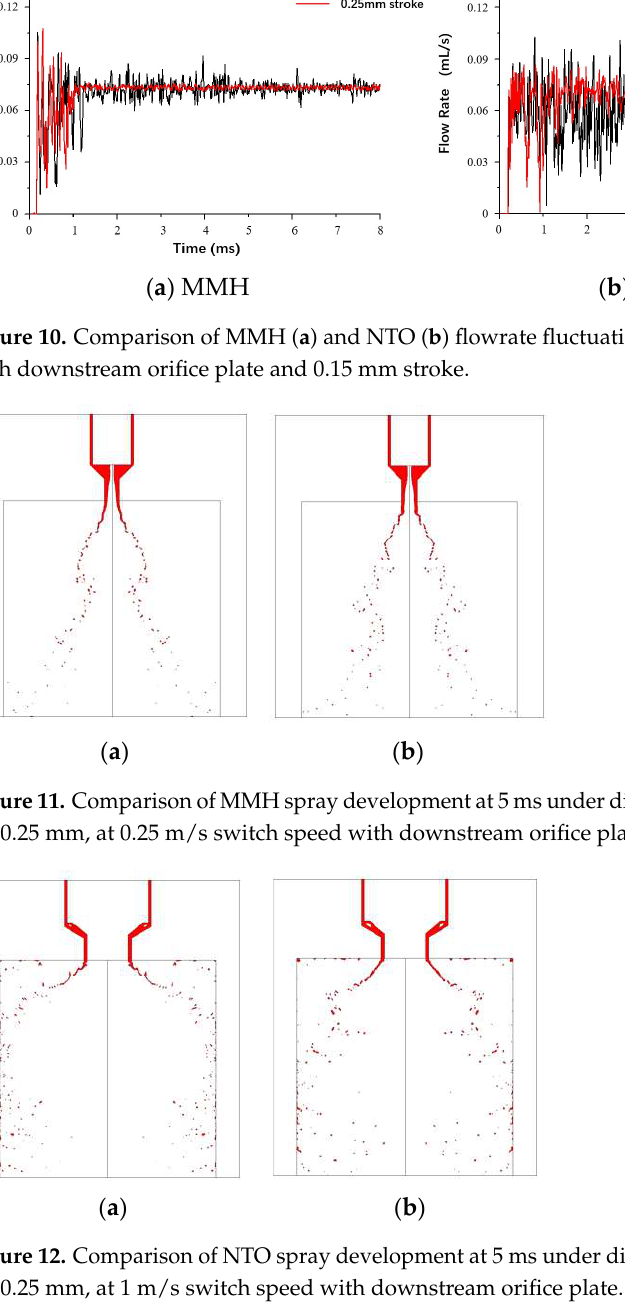
( c ) Figure 9. Comparison of NTO spray development at 5 ms under different switch speeds: ( a ) 0.125 m/s, ( b ) 0.25 m/s, ( c ) 1 m/s, with downstream orifice plate and 0.15 mm stroke.